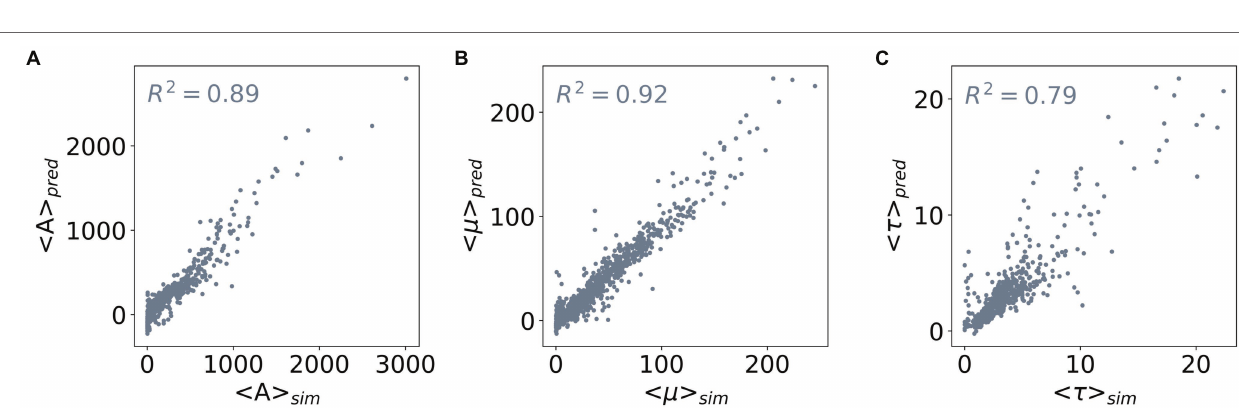
FIGURE 3 | Correlation between the three outputs and their two most important inputs. (A–C) are the results from the subset with steptime of 0.1 min and (D–F) are from that with steptime of 1.1 min. The most important input is shown in the x -axis, whereas the second most important input is shown in the y -axis. The average values <A> (A,D) , < μ > (B,E) , and < τ > (C,F) are illustrated as heat maps.